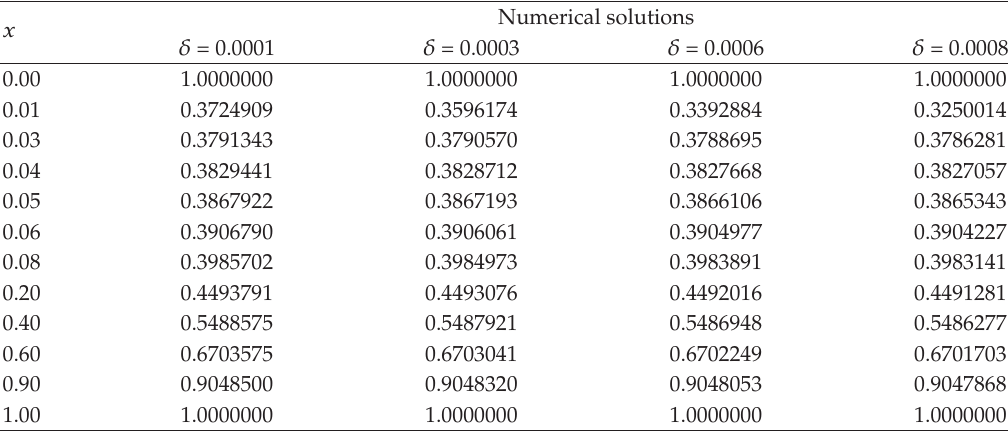
Table 7: Numerical results of Example 4.3 for ε (cid:8) 0 . 001, N (cid:8) 100, and di ff erent values of δ .